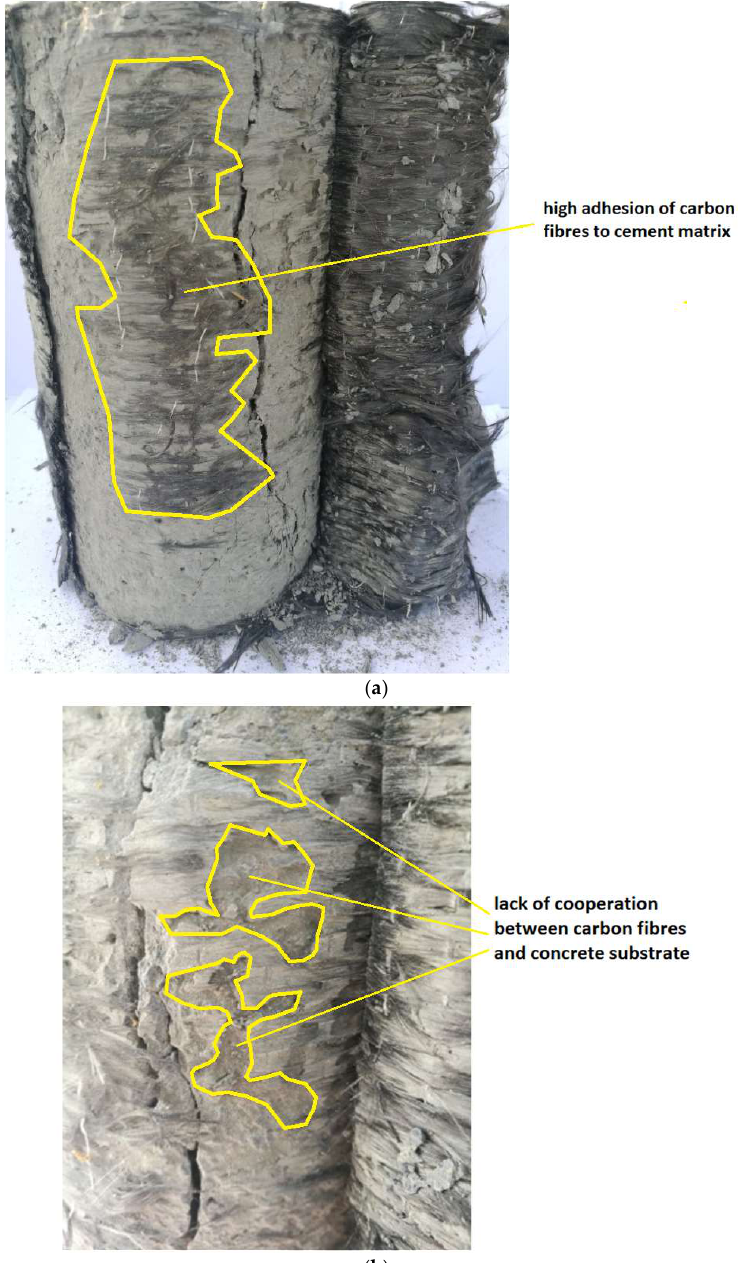
Figure 11. Analysis of the failure of the connection between the carbon fiber reinforced with the cement matrix and the sanded concrete surface: view of the entire sample ( a ) and enlargement of the extrusion area of the cement matrix ( b ).